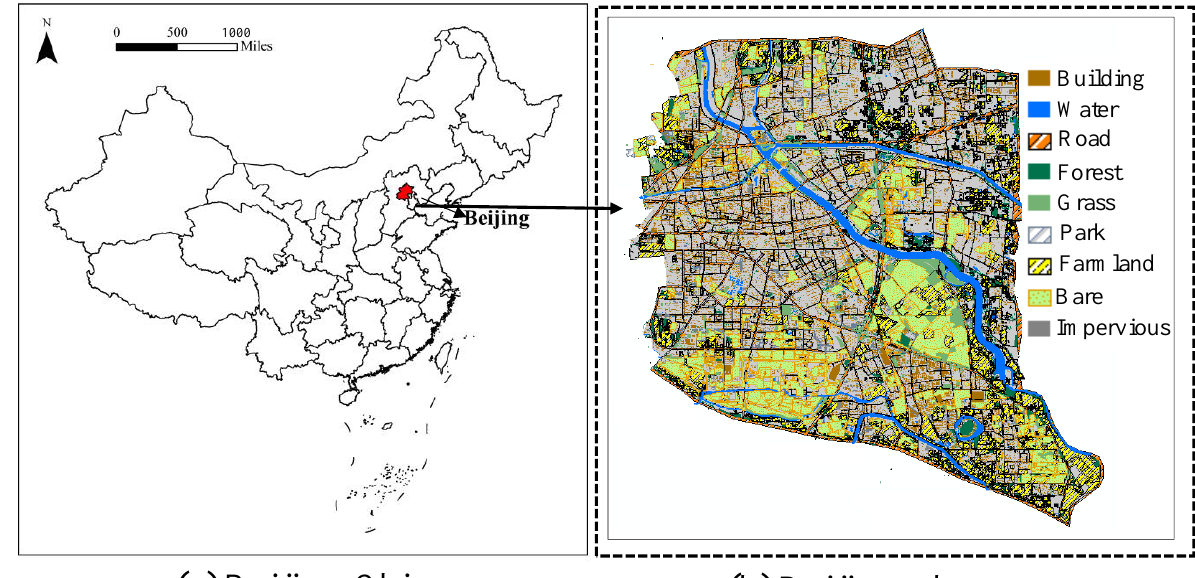
Figure 1. Study Figure 1. Study area.